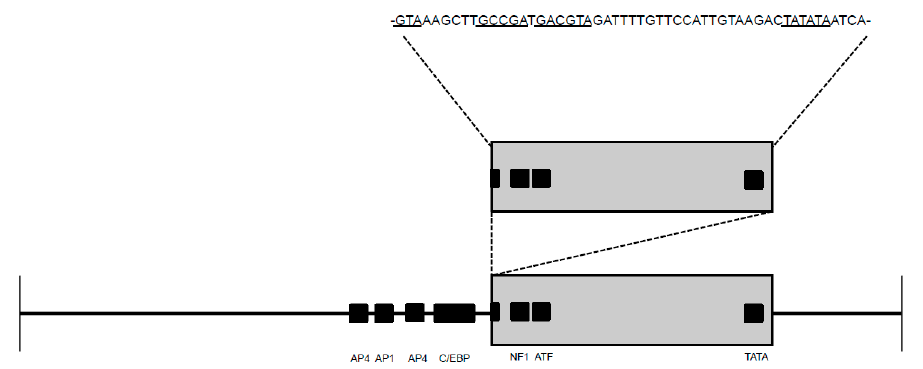
Figure 5. FIV proviral LTR mutated clone amplified from blood-derived CD21+ leukocytes from one cat (186). A 52 base pair direct repeat (grey rectangle) in U3 region includes both the NF1 (bipartite) and ATF transcription factor binding sites and TATA box (underlined and black boxes), resulting in duplication of these U3 sites.